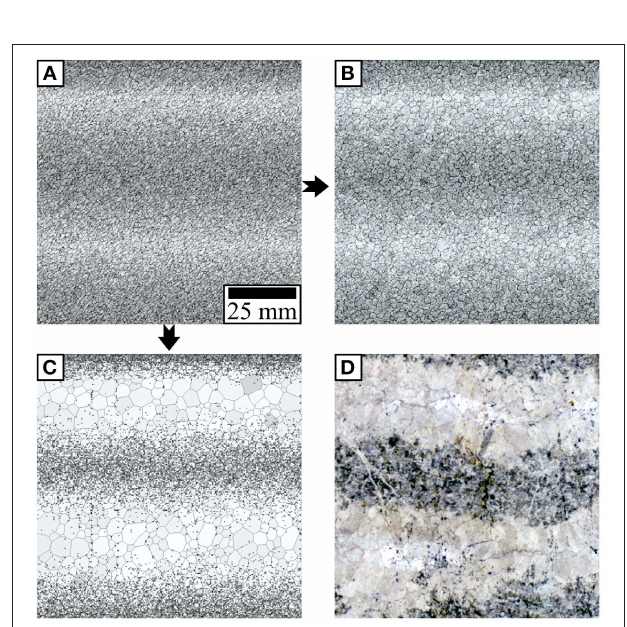
FIGURE 9 | (A) Initial distribution of second-phase particles for the simulations in (B,C) . (B) Result of a grain growth simulation without the redistribution performed by the reaction front after 3500 time steps. A stable grain size is reached and no pronounced banding is observable. (C) Result of s simulation of dolomitization followed by grain boundary migration after 30,000 time steps. The redistribution of the second-phase material leads to a bifurcation in grain growth rates and this causes banding. (D) Scan of a thin section. The area of the scan is equivalent to the area of the simulation. The location of the dark and light layers as well as the grain size differences are in good agreement with the result of the simulation shown in (B)